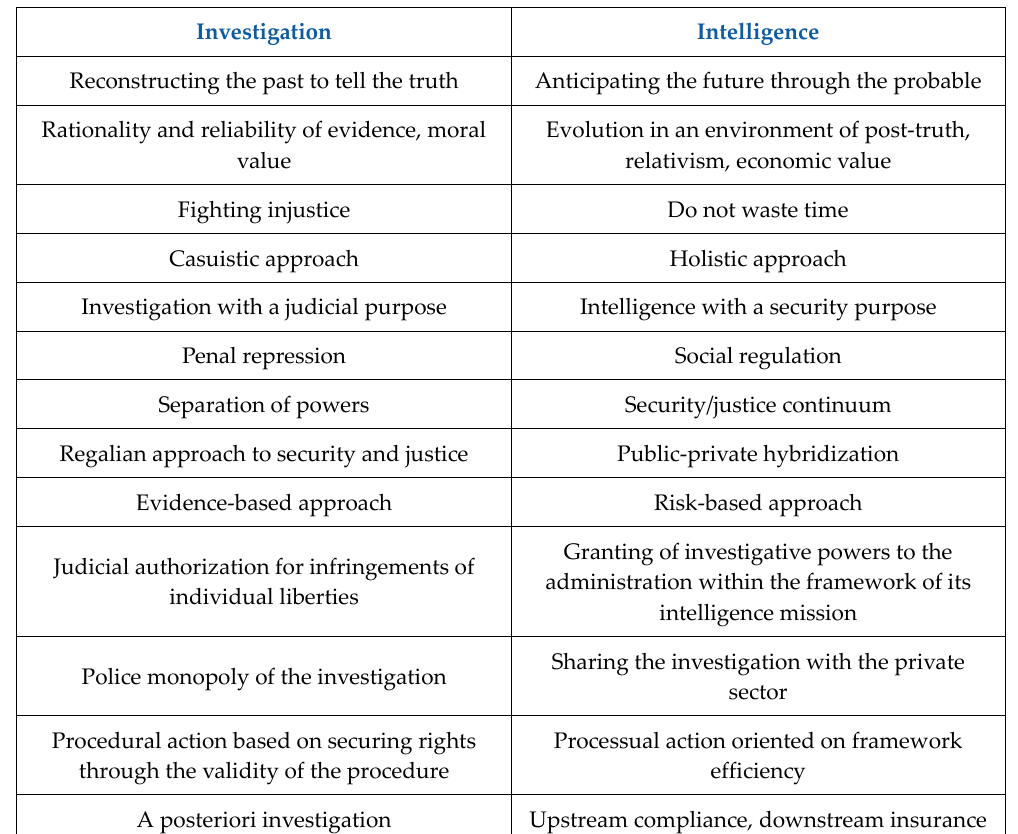
Figure 3. Paradigm shift between investigation and intelligence.